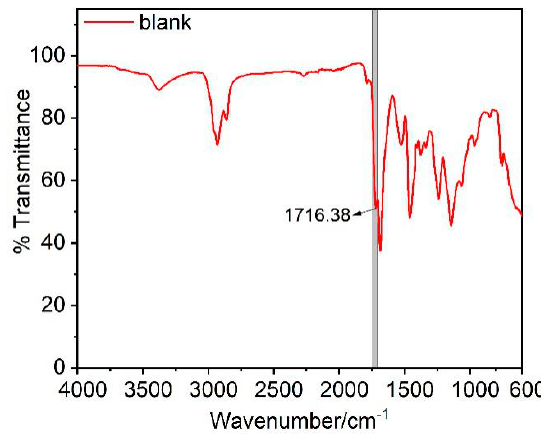
Figure 6. Integral area of the carbamate carbon’s characteristic peak of the blank sample.